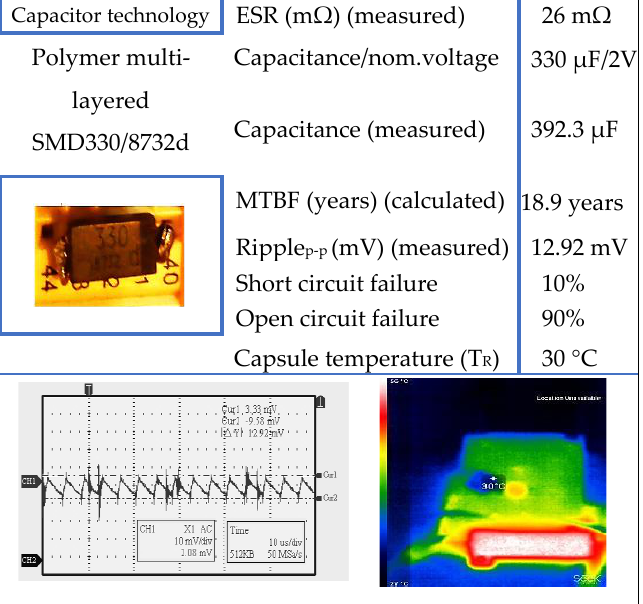
Figure 12. Data taken from measurement, photo of capacitor Ta-polymer 2R5TPE330M7 as DUT (left – center), the actual the ripple’s waveform (left) and surface capacitor’s temperature which is required in reliability calculation (right).